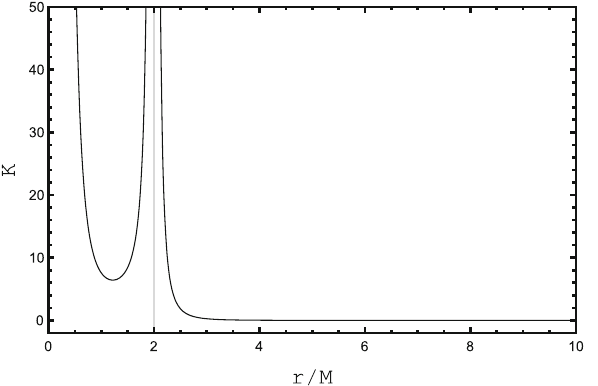
Fig. 2 Kretschmann scalar for ε = − 8, with the surface-like singular- ity located on the event horizon of the JPBH